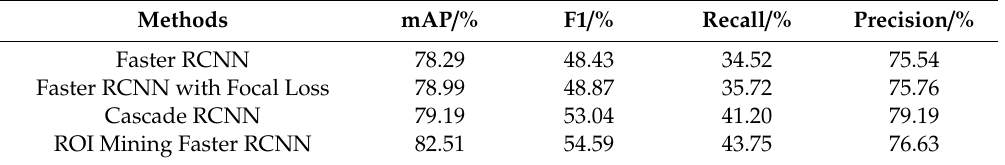
Table 5. Detector